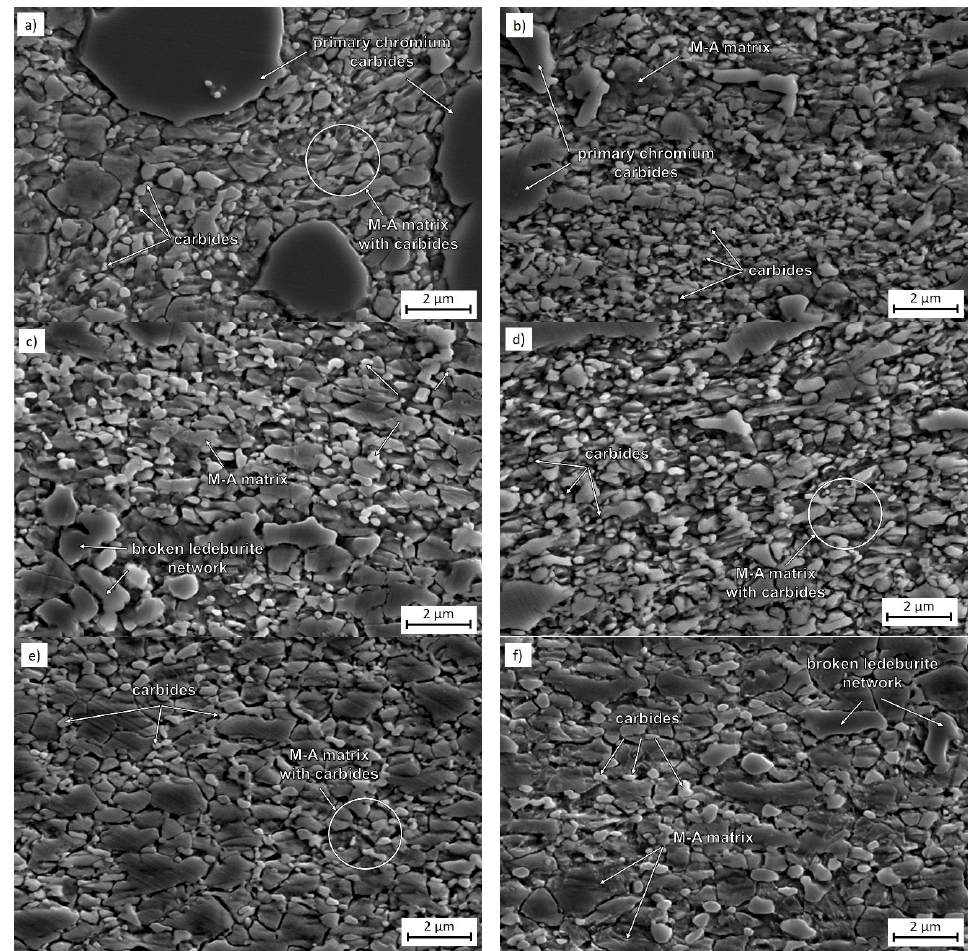
Figure 7. Detail micrographs from scanning electron microscope of semi-solid-processed and subsequently press-formed material: ( a ) 1200 °C/water (regime 1); ( b ) 1220 °C/water (regime 2); ( c ) 1240 °C/water (regime 3); ( d ) 1280 °C/water (regime 4); ( e ) 1240 °C/oil (regime 5); ( f ) 1240 °C/oil–250 °C/60 min (regime 6), scanning electron micrographs.